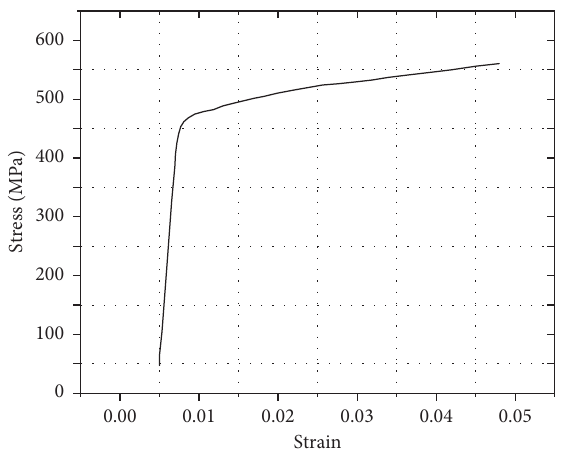
Figure 5: Tensile stress-strain curve of steel pipe